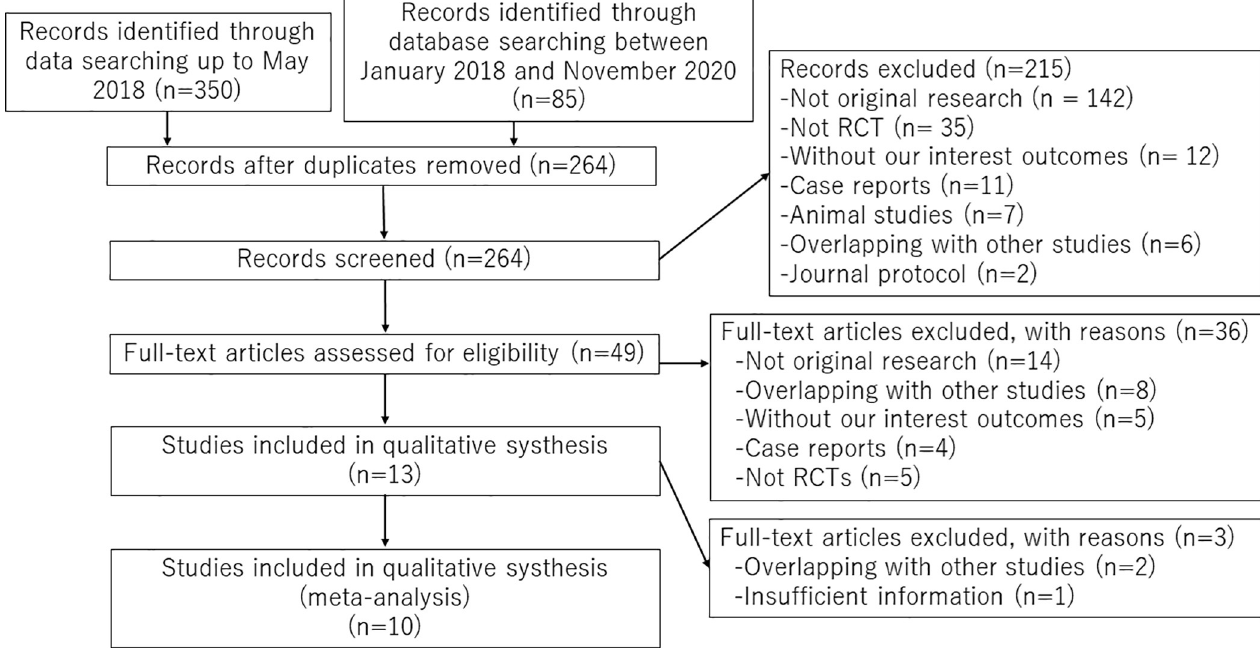
Fig 1. Process of study